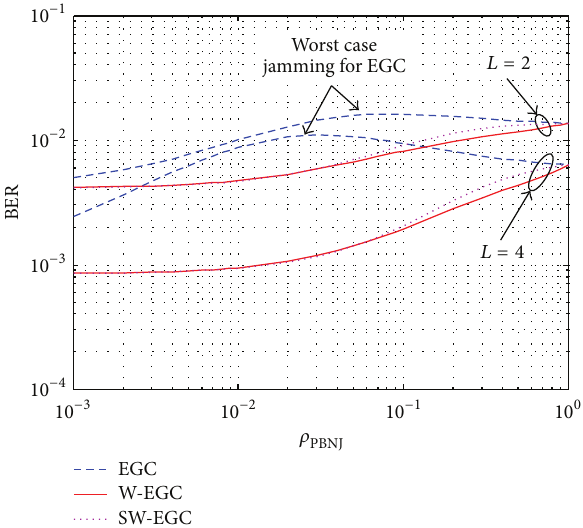
Figure 2: BER of FFH/BPSK with W-EGC and EGC versus 𝜌 𝐿 = 2 and 4, 𝐸